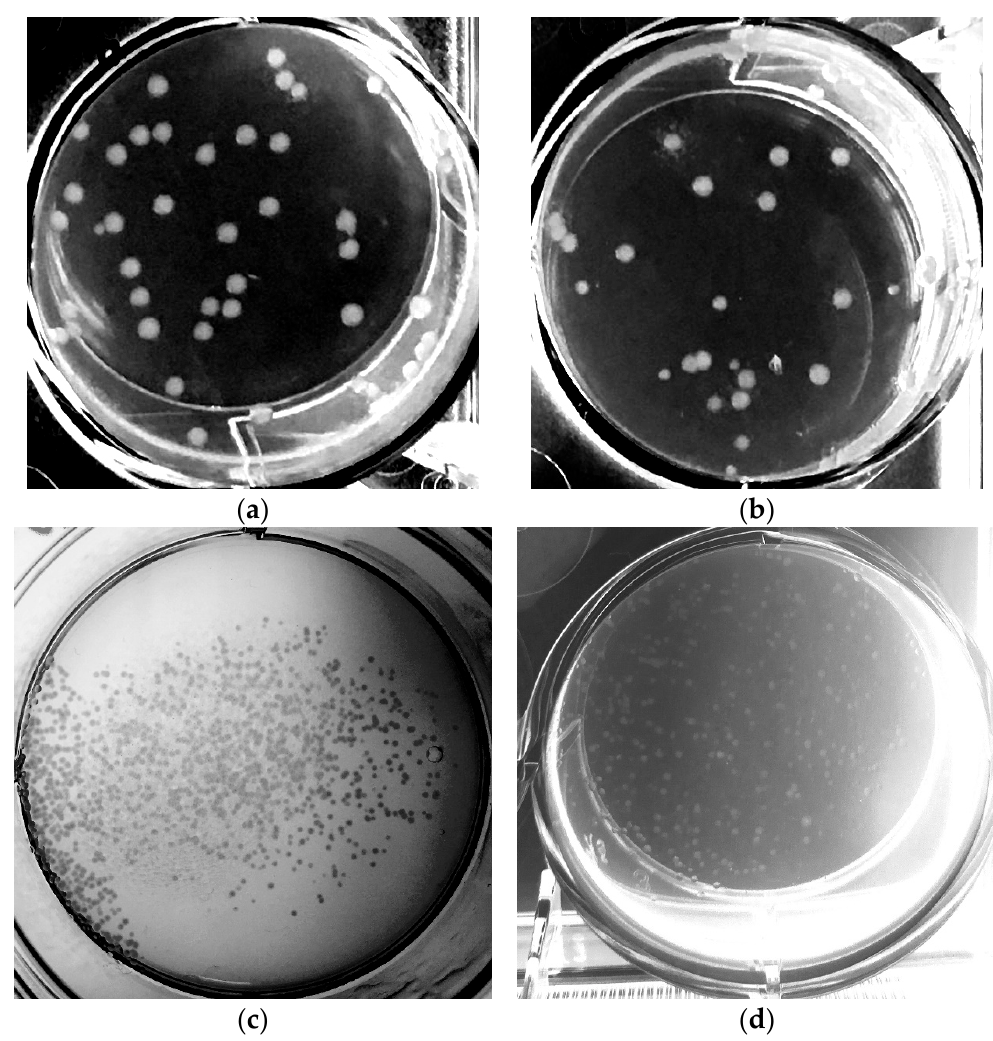
Figure 7. Spread cells after treatment for competence and transformation in 6-well plates ( a ) manually on ice; ( b ) manually at 4 °C instead keeping cell on ice; ( c ) automated treatment with a batch for cell on ice; ( b ) manually at 4 ◦ C instead keeping cell on ice; ( c ) automated treatment with a batch for cell harvesting; ( d ) automated treatment with quasi-turbidostat for cell harvesting. harvesting; ( d ) automated treatment with quasi-turbidostat for cell